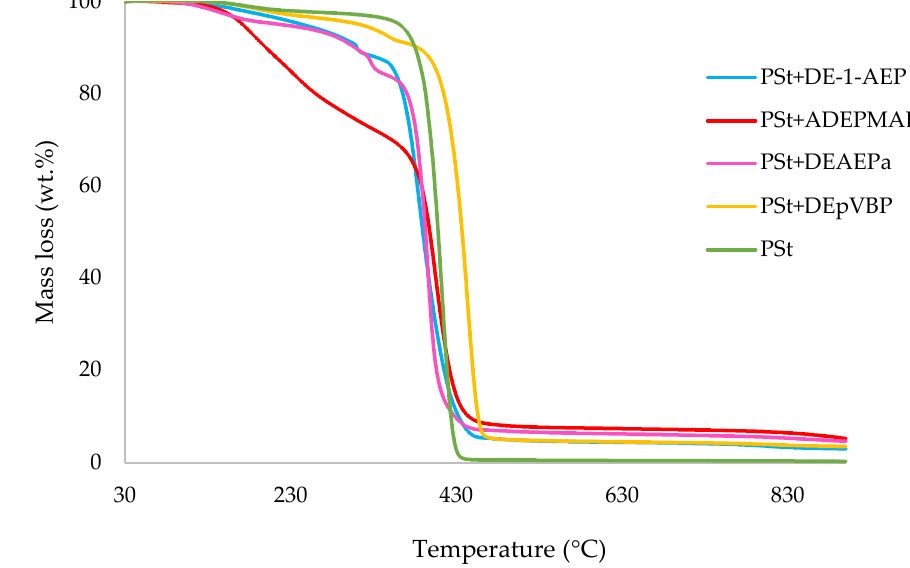
Figure 3. An overlay of TGA curves of the PSt-based materials with reactives, at 10 °C min −1 in nitrogen, from 30 to 900 °C.